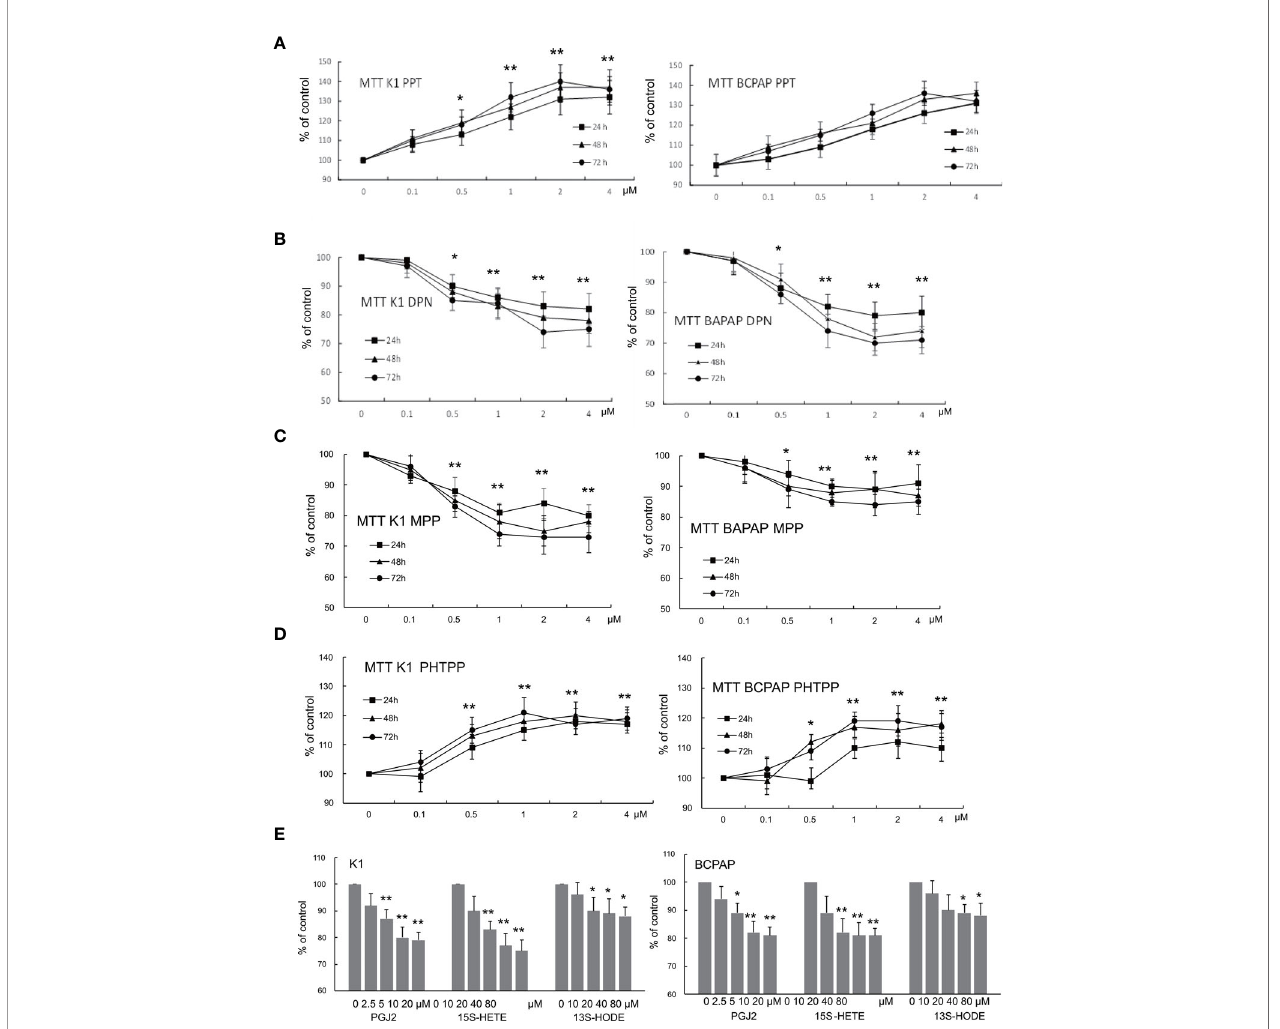
FIGURE 3 | The impact of ER modulation and endogenous PPAR g ligands on cell growth. K1 and BCPAP cells were respectively treated with PPT (A) , DPN (B) , MPP (C) , and PHTPP (D) at the given concentrations for 24, 48 and 72 hours. At the end of the treatment, cell survival was measured by MTT assay to estimate the cell growth and expressed as the percentage of control culture conditions (no treatment). To assess the effect of endogenous PPAR g ligands on cell growth, different doses of PGJ2, 15(S)-HETE and 13(S)-HODE, as indicated in the fi gure, were used to treat K1 and BCPAP for 48 hours (E) , and cell growth was determined by the survival assay as described above. The data were presented as the mean ± SD of 3 independent experiments with triplicate wells. *p < 0.05, **p < 0.01, compared with the control (0